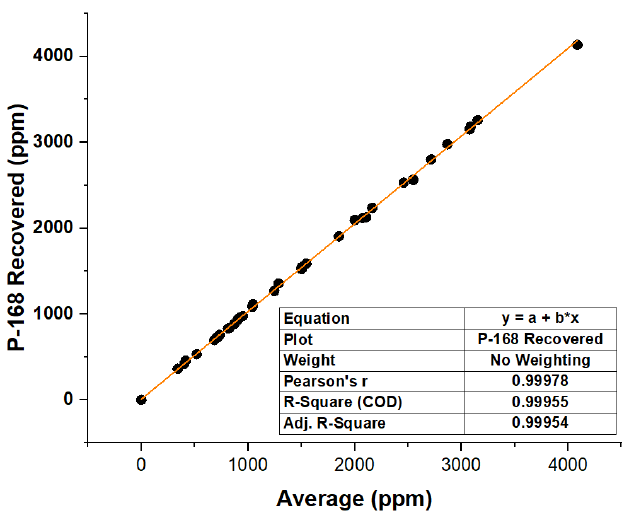
Figure 8. Average SPE concentrations of standards versus average concentration recovered from the samples. the